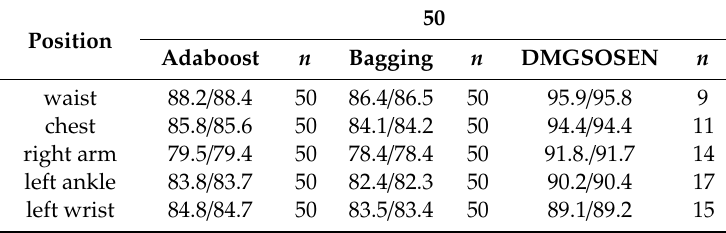
Table 11. Performance comparison with Adaboost and Bagging on 50 ELMs (Accuracy /